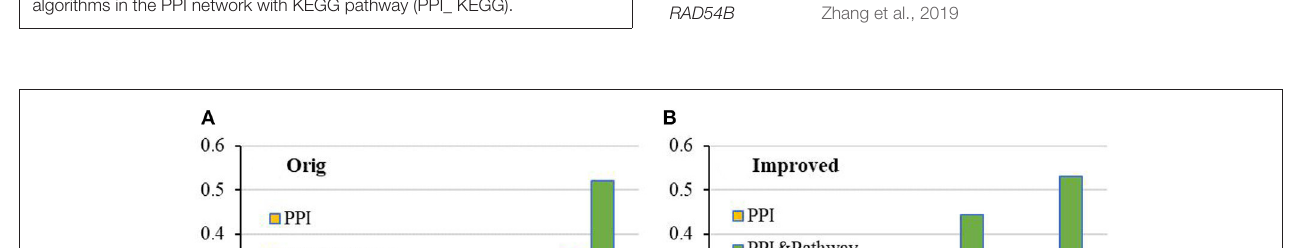
FIGURE 5 | Top- k Recall ( k 1, 5, 10, 20%) of the original and improved = algorithms in the PPI network with KEGG pathway (PPI_ KEGG).